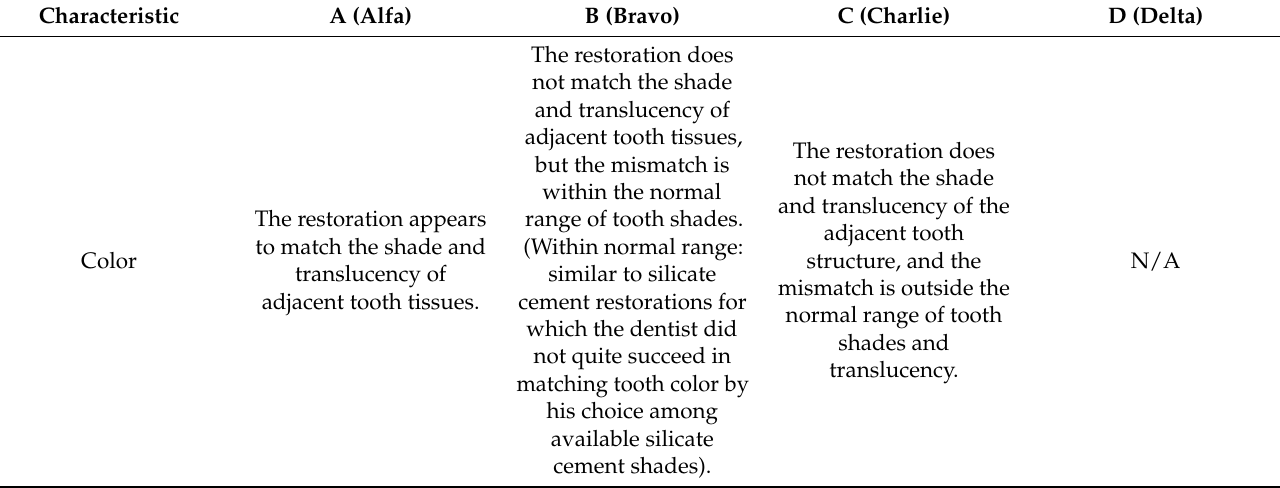
Table 1. USPHS criteria for clinical evaluation of restoration [30]. Adapted from ref.